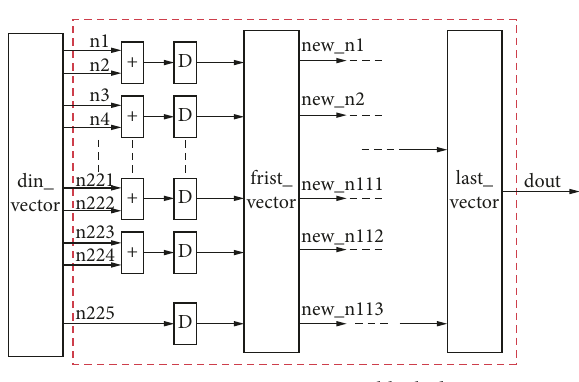
Figure 3: 15 15 window cache ×